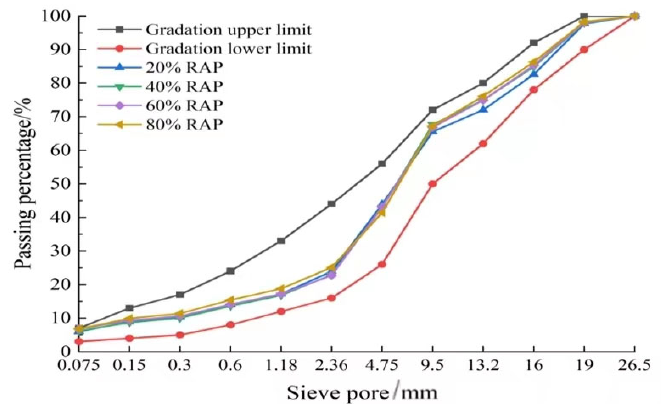
Figure 4. Four kinds of RAP mixing level distribution